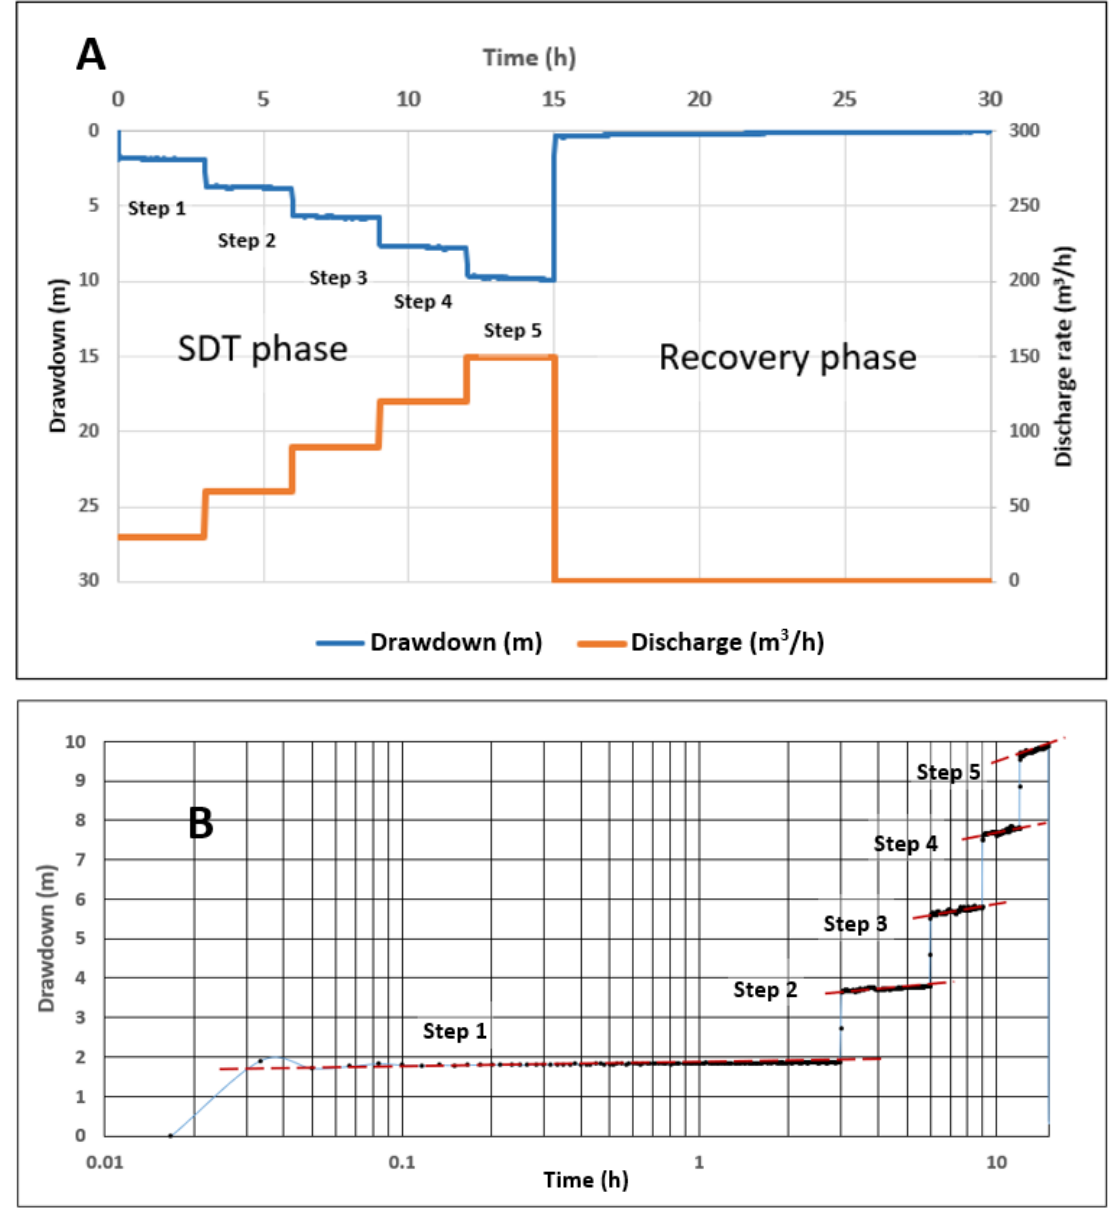
Figure 4. Example of step drawdown test (SDT) progress. Well RW002. ( A ) Arithmetic plot of the discharge rate and drawdown variation at each step. ( B ) Semi-logarithmic plot of drawdown vs. time, showing the evolution of drawdown during each step.